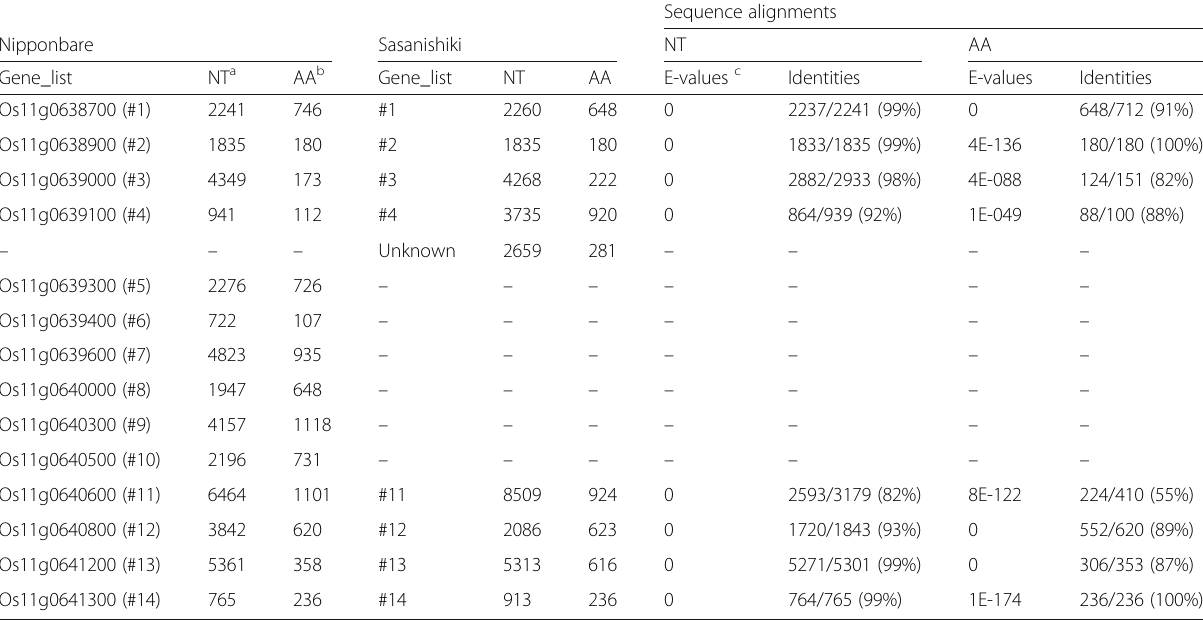
Table 1 Comparison of the sequences of genes Os11g0638700 to Os11g0641300 between Nipponbare and Sasanishiki